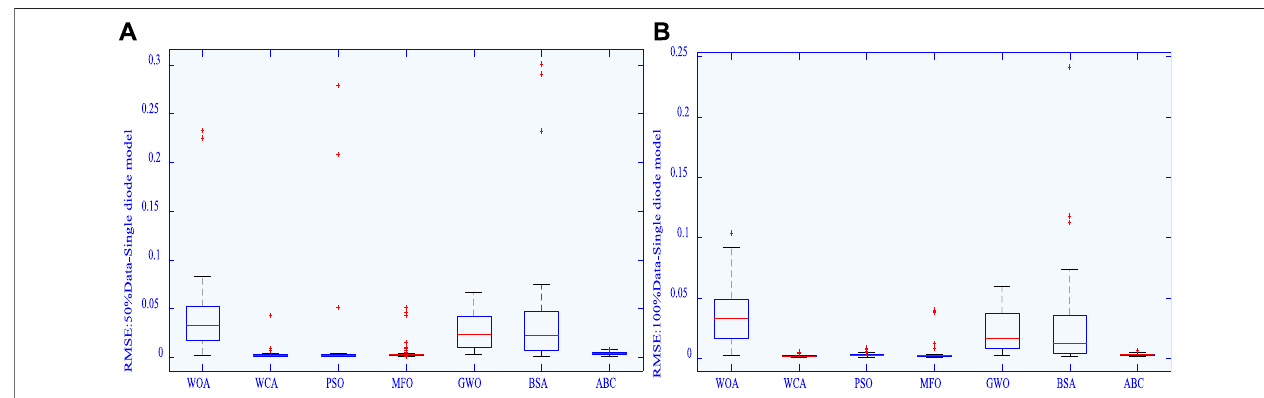
FIGURE 4 | Boxplot of RMSE obtained by various algorithms in different data for the SDM: (A) 50% data and (B) 100% data.